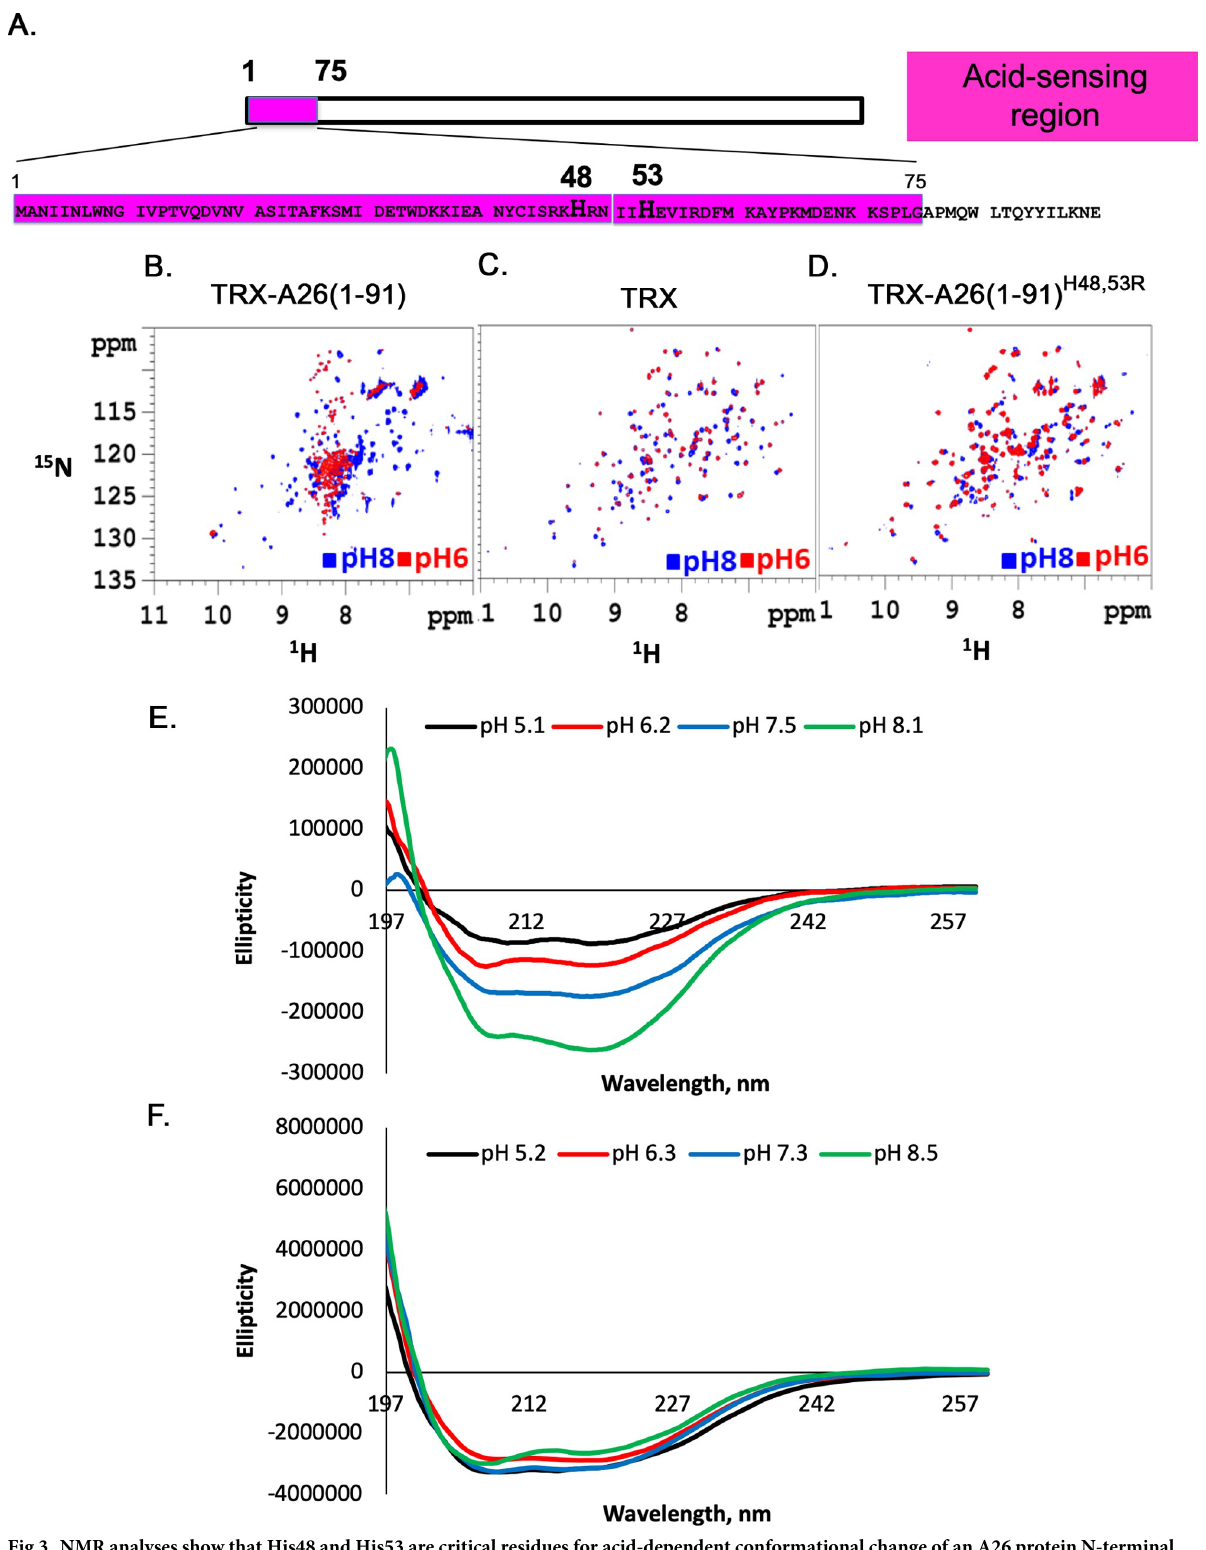
Fig 3. NMR analyses show that His48 and His53 are critical residues for acid-dependent conformational change of an A26 protein N-terminal fragment (aa 1–91) in vitro . (A). Protein sequence of the N-terminal of vaccinia WR-A26 protein (aa 1–91), showing positions of His48 and His53